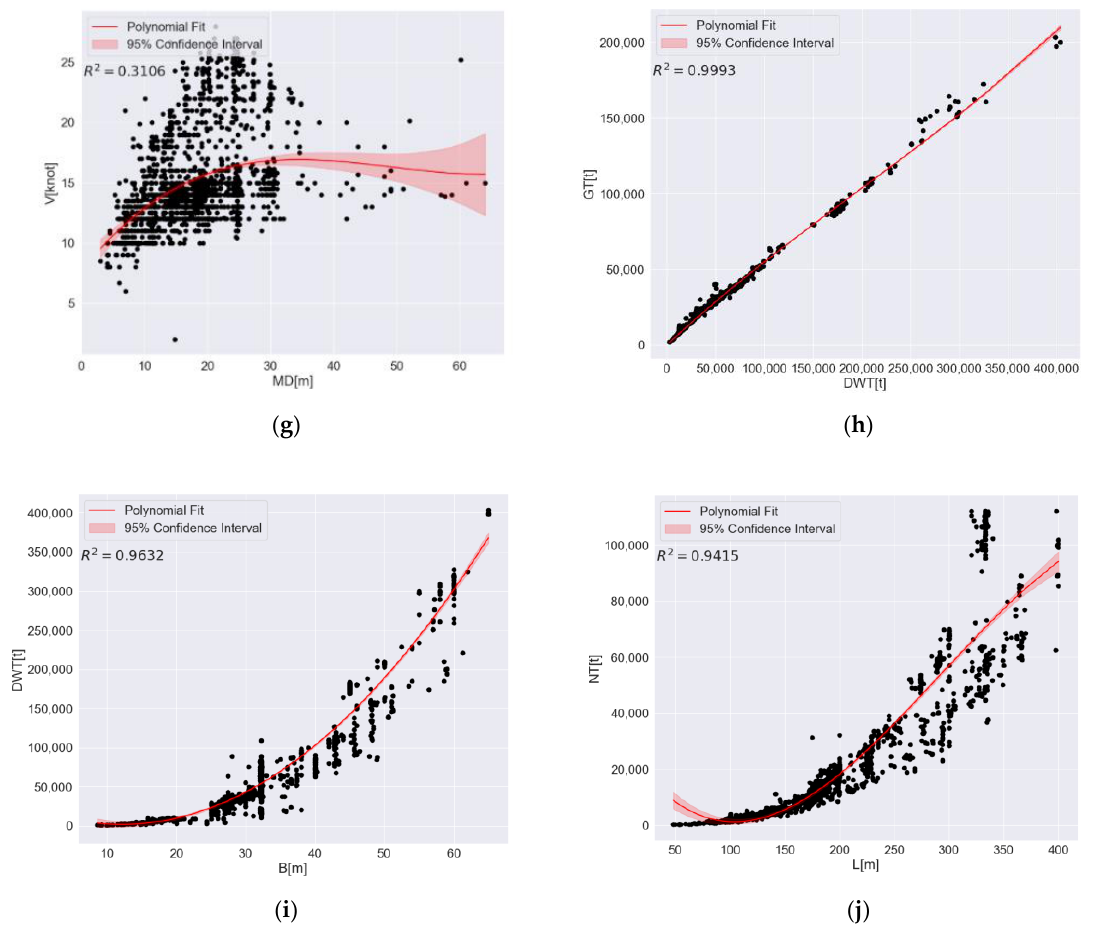
Figure 5. Polynomial fitting results for the main design parameters of the ship: ( a ) L, ( b ) B, ( c ) MD, ( d ) MEP, ( e ) AEP, ( f ) BP, ( g ) V, ( h ) GT, ( i ) DWT, and ( j ) NT. The black dots are the pre-processed data. Table 5. The coefficients of the polynomial fit function. Functional expression: y = k 0 + k 1 · x + k 2 · x 2 + k 3 · x 3 .